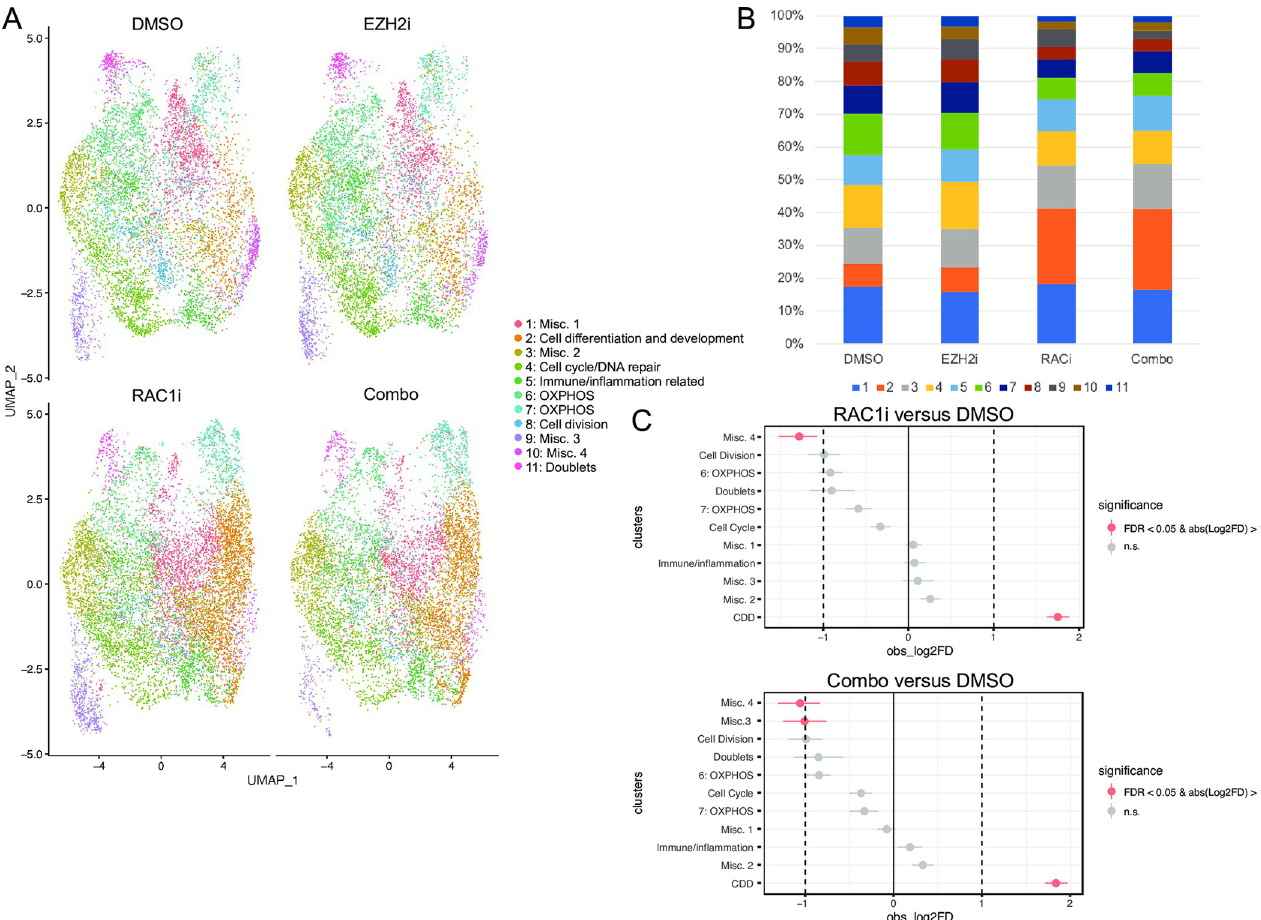
Fig 2. RAC1i treatment changes the relative proportion of cells in different clusters. (A) Individual UMAP dot plots of DMSO, EZH2i (GSK126, 5 μ M, 48H), RAC1i (NSC23766, 50 μ M, 48H), and Combo (RAC1i + EZH2i) scRNA-seq samples colored by cluster. (B) Relative proportion of cells in each cluster for each sample type. (C) Relative differences in cell proportions for each cluster between RAC1i versus DMSO and combo treatment versus DMSO. Red clusters have an FDR < 0.05 and mean | Log2 fold enrichment | > 1 compared with the normal colon (permutation test; n